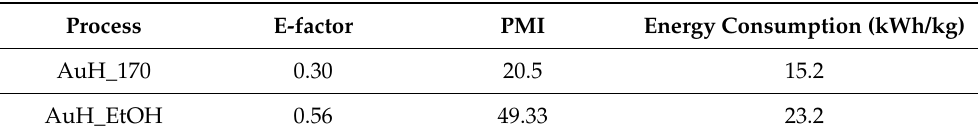
Table 4. E-factor, PMI, and energy consumption values for the auto-hydrolysis cellulose extraction process (170 ◦ C, 1 h) and auto-hydrolysis (170 ◦ C, 1 h) associated with organosolv with ethanol 50% ( v / v ) (190 ◦ C, 2.5 h) from SCB (fraction > 315 µ m). Process